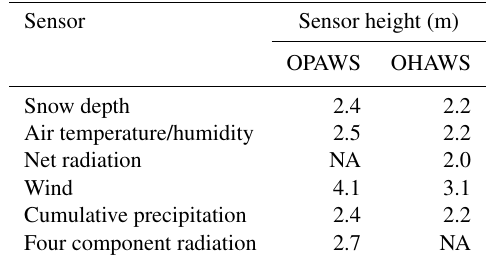
Table 1. Current sensor height measurements at OHAWS and OPAWS. A more complete record of sensor height changes over the 2004–2017 monitoring period is available in Table S4 in the Supplement. NA denotes data that are not available.